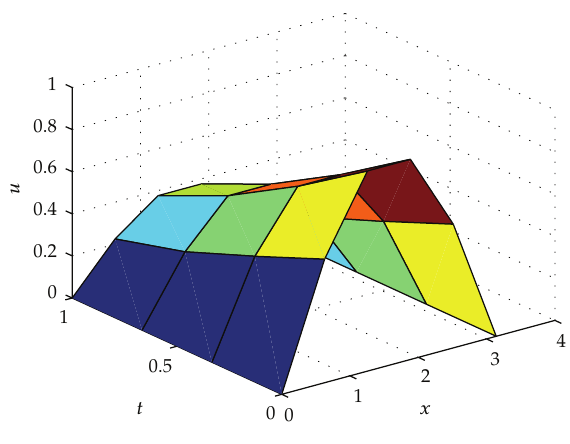
Figure 4: Numerical solution.